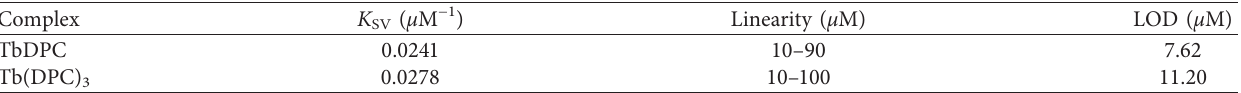
Table 4: Analytical parameters for ATP monitoring by pyridinedicarboxylate-Tb(III) probes (24 mg/L) in Tris-HCl buffer (pH 7.4).